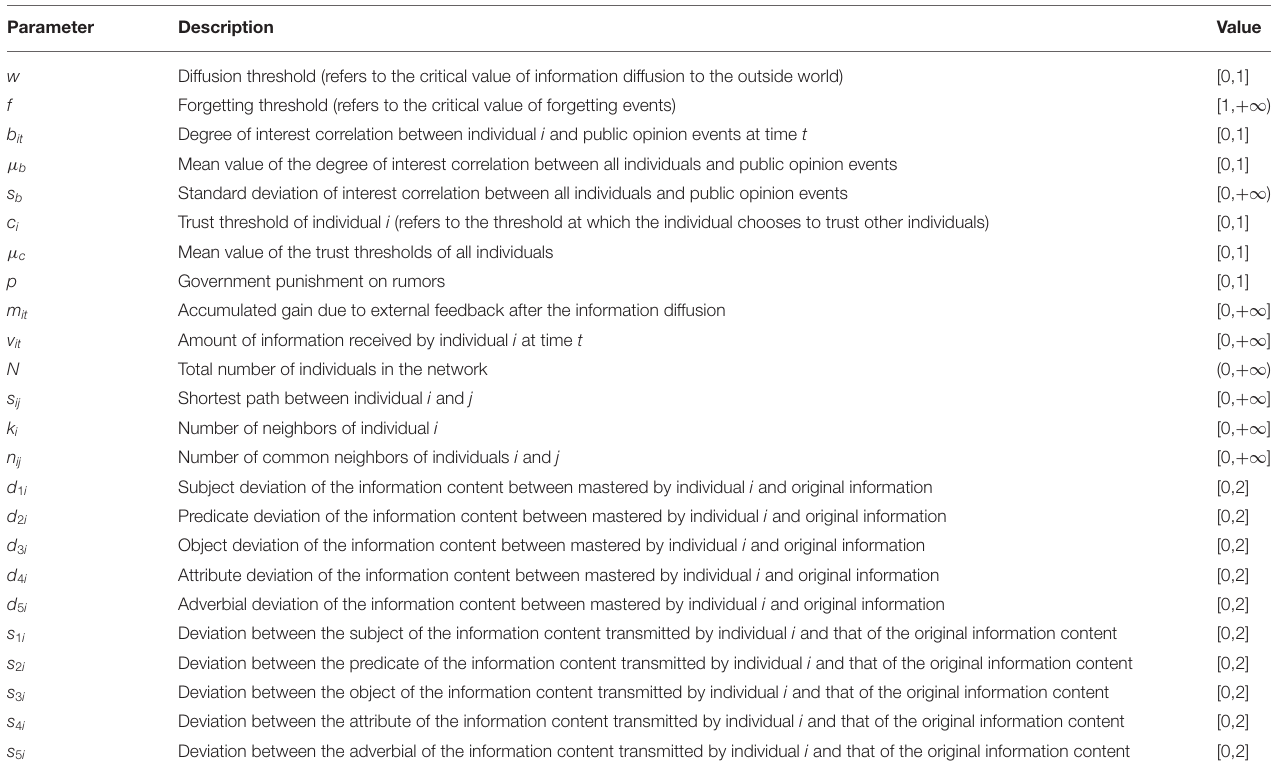
TABLE 1 | Involved parameters in the model.